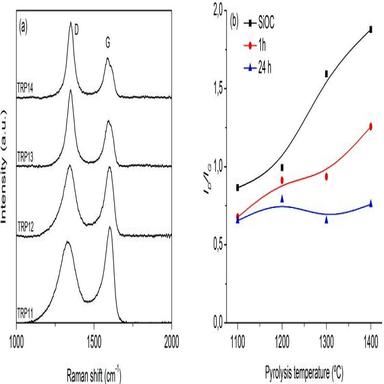
(a) Raman spectra of TRP SiOC derived materials and (b) ID/IG evolution from SiOC to SiOC-DC pyrolyzed and etched under different conditions.